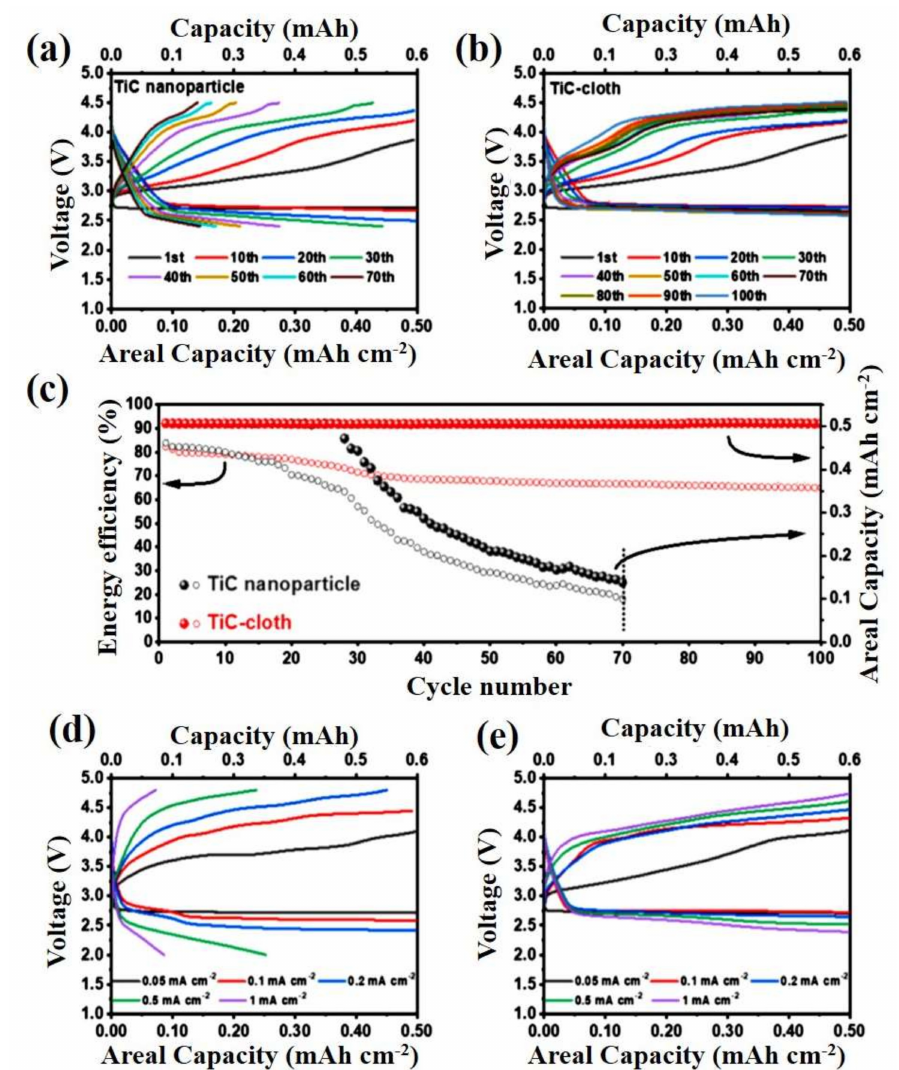
Figure 5. Galvanostatic charge-discharge (GCD) plot for an LOB using ( a ) a titanium carbide (TiC) nanoparticle (NP) cathode @ 0.1 mA cm − 2 for a duration of 5 h and ( b ) a TiC-cloth cathode @ 0.1 mA cm − 2 for a duration of 5 h. ( c ) Relationship between the areal capacity, energy e ffi ciency, and number of cycles. ( d ) Discharge plot for various current densities with a TiC NP cathode. ( e ) Discharge plot for various current densities with a TiC-cloth cathode [75]. Copyright 2020